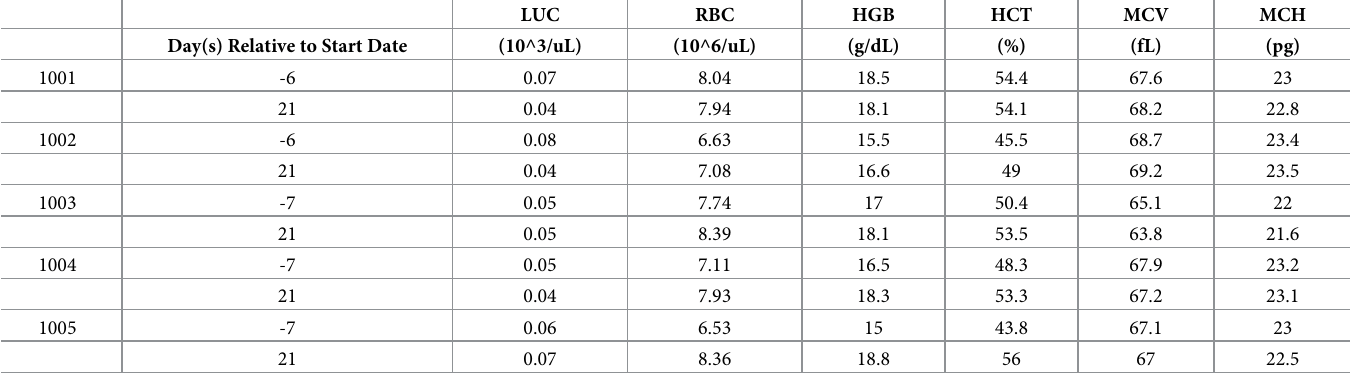
Table 2. Hematology reporting for each animal for LUC, RBC, HGB, HCT, MCV, and MCH. LUC RBC HGB HCT MCV